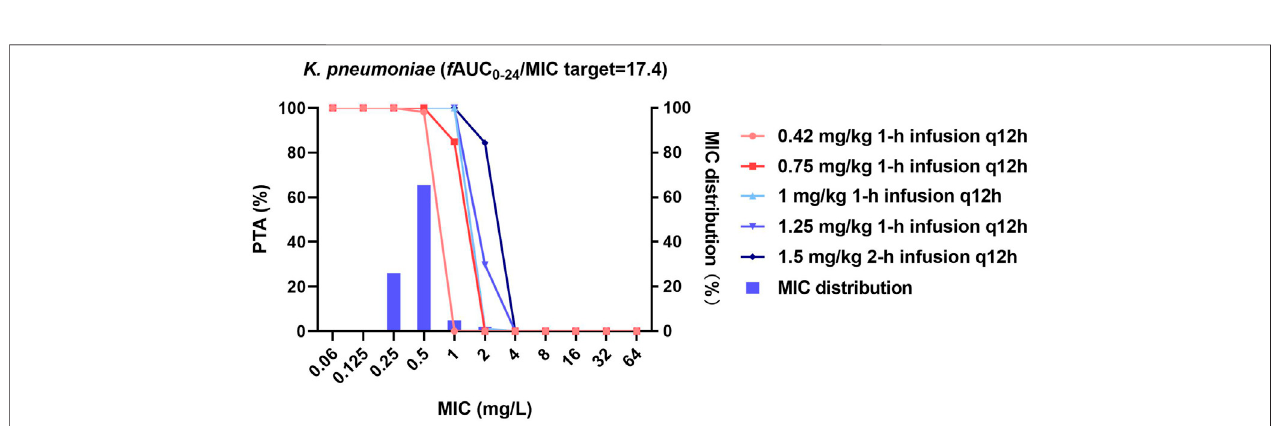
FIGURE 3 | MIC distribution and PTA of different dosing regimens against K. pneumoniae . MICs of > 32 mg/L are represented by 64 mg/L; PTA was determined using the AUC 0 – 24h at steady state. The f AUC 0 – 24h /MIC target of 17.4 represents a 1-log 10 CFU reduction.